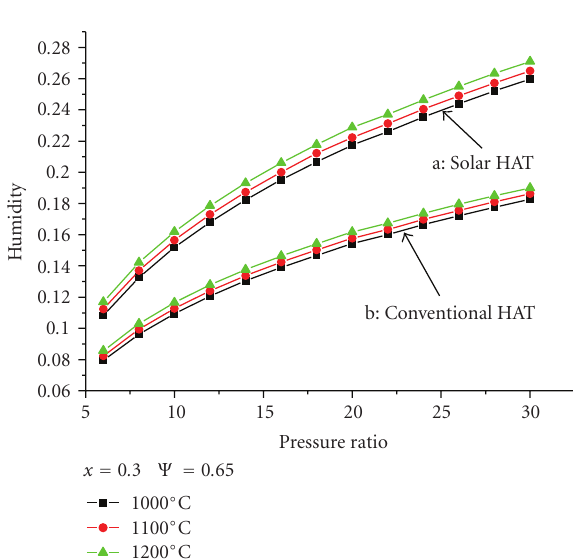
604.7 kJ/kg for the proposed cycle, improving 84.8 kJ/kg.